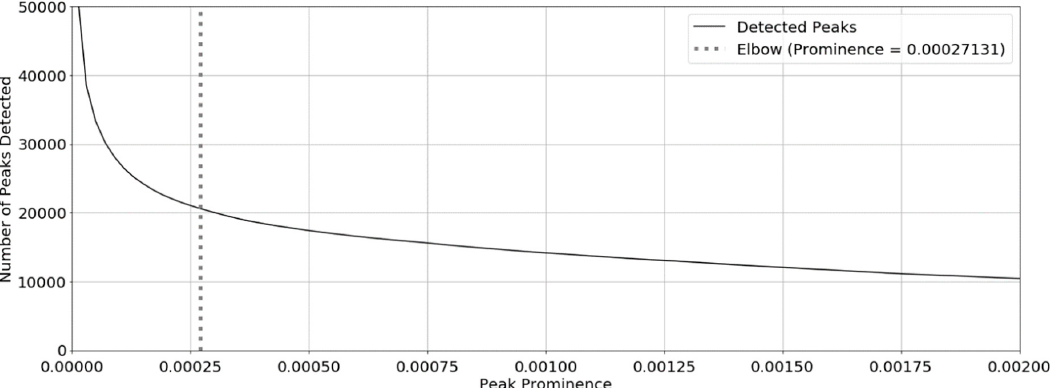
Figure 8. The sensitivity analysis of the peak prominence filter. The black trace is the number of detected peaks against prominence. The dashed vertical line corresponds to the location of the elbow determined using the technique in Reference [39].